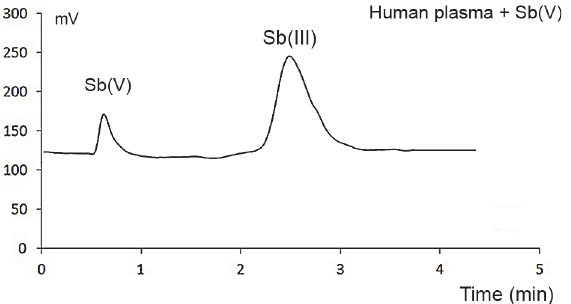
Figure 2. Chromatogram of blood plasma incubated with 200 ng mL − 1 Sb(V) + 5 mmol L − 1 GSH. * No trimethyl-Sb(V) was detected. * Incubation was performed in triplicate using collection tubes from single donor ’ s blood